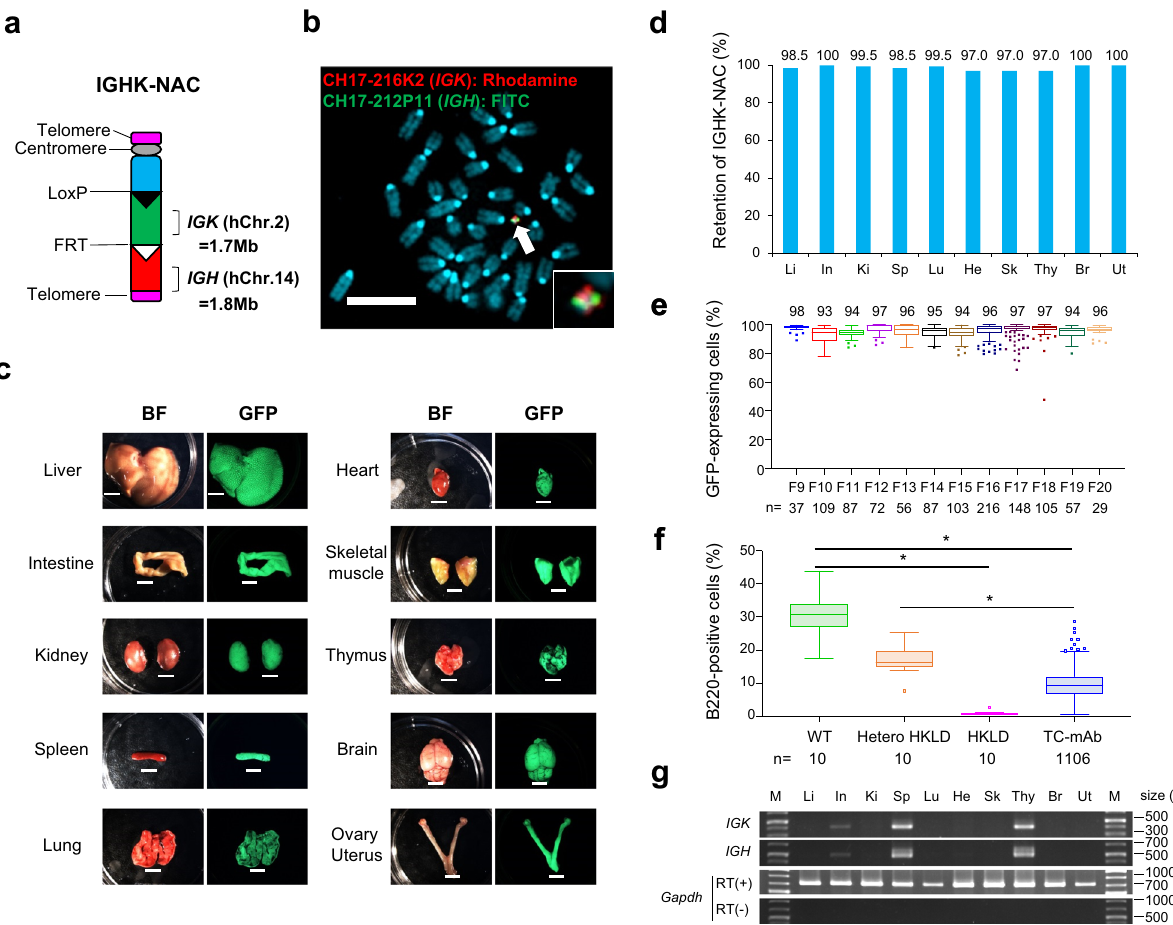
Fig. 1 Generation of fully human Ab-producing mice. a Representation of the IGHK-NAC structure. Human Ig heavy chain locus ( IGH ) derived from hChr.14 and Ig kappa light chain locus ( IGK ) derived from hChr.2 are represented on a mouse arti fi cial chromosome (MAC). b Representative image of metaphase FISH analysis with IGK-BAC (CH17-216K2) (red) and IGH-BAC (CH17-212P11) (green) detecting the IGHK-NAC in bone marrow cells from a TC-mAb mouse. Arrow indicates the IGHK-NAC and the inset shows an enlarged image thereof. Scale bar (10 μ m). c GFP images of different tissues from a Tc mouse carrying the IGHK-NAC. GFP expression indicates the presence of the IGHK-NAC. BF, bright fi eld. Scale bar (5 mm). d Retention rate of the IGHK-NAC in various Tc mouse tissues analysed by FISH. Li liver, In intestine, Ki kidney, Sp spleen, Lu lung, He heart, Sk skeletal muscle, Thy thymus, Br brain, Ut uterus. e Percentage of GFP-expressing cells in peripheral blood mononuclear cells from Tc mice of different generations. f Percentage of B220- positive cells in the lymphocyte fraction of peripheral blood in age-matched WT ( n = 10), hetero HKLD ( n = 10, Igh + / − , Igk + / − and Igl 1 + /low ), HKLD ( n = 10, Igh − / − , Igk − / − and Igl1 low/low ) and TC-mAb mice ( n = 1106). Box plots are indicated in terms of minima, maxima, centre, bounds of box